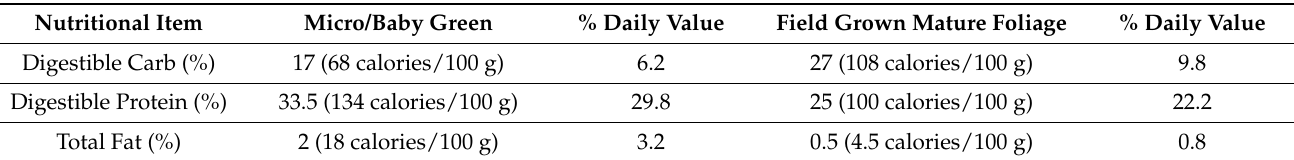
Table 3. Roselle: nutritional value of 100 g (dry weight) micro/baby green and mature field grown foliage. Figures show average for 10-, 15-, and 20-day-old micro/baby green and average for 7- and 9-week-old field grown plants. Daily value assumptions: Carbohydrates—1100 calories (Range 900–1300); Protein—450 calories (Range 200–700); Fat—550